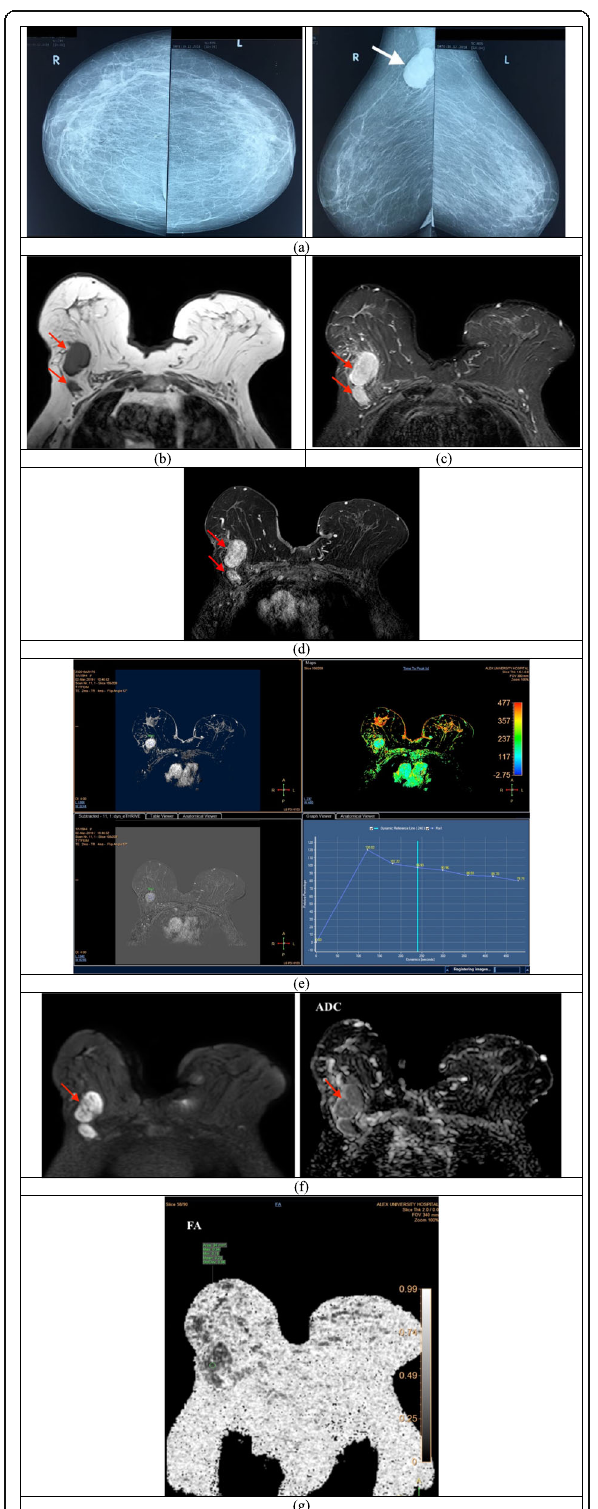
Fig. 5 70-year-old female presented with right axillary tail lump. a Mammogram, two overlapping partially circumscribed dense lesions noted at axillary tail of right breast (BIRADS 4c). CE-MRI ( b ) axial T1 showed oval-shaped isointense lesions with smooth margins. c Axial STIR, the lesions showed hyper intense signal. d Axial dynamic THRIVE showed heterogeneous intense enhancement, with type III dynamic curve of enhancement ( e ). f DWI showed